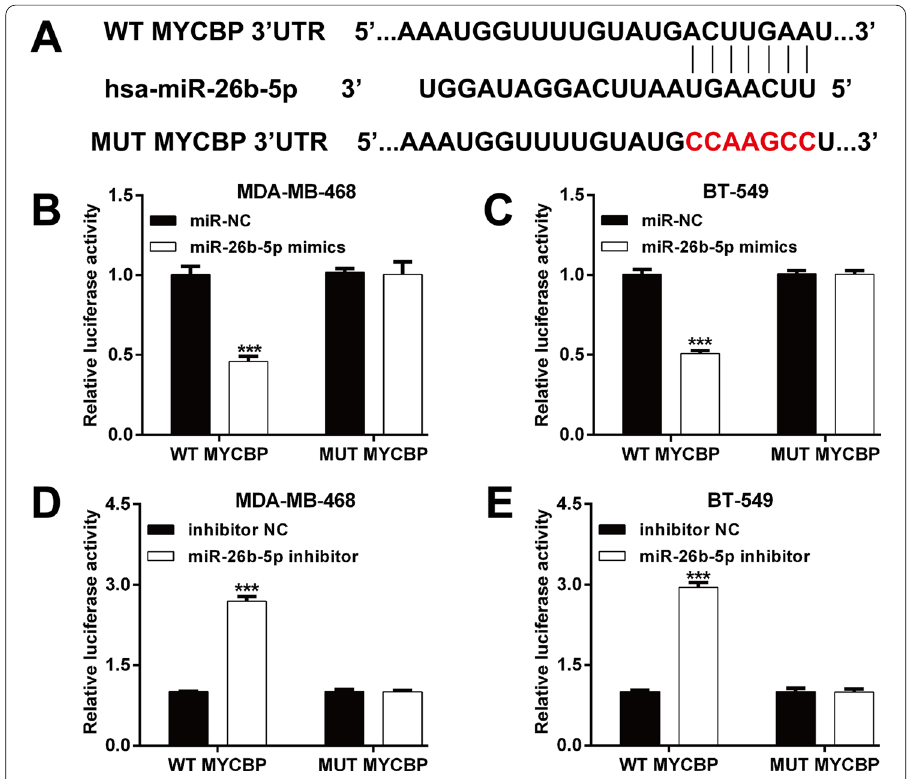
Fig. 1 MYCBP is a direct target of miR-26b-5p. A The binding site for miR-940 in the 3- ′ UTR of FOXO3 predicted by bioinformatics was presented. Luciferase reporter assay evaluation of the interaction between miR-26b-5p and the 3 ′ -UTR of MYCBP mRNA. Luciferase activity was determined 48 h after co-transfection of luciferase constructs containing the wild-type (WT) or a mutated (MUT) 3 ′ -UTR of MYCBP mRNA and miR-26b-5p mimics or miR-NC in MDA-MB-468 ( B ) and BT-549 ( C ) cells. Luciferase activity was determined 48 h after co-transfection of luciferase constructs containing the WT or a MUT 3 ′ -UTR of MYCBP mRNA and miR-26b-5p inhibitor or inhibitor NC in MDA-MB-468 ( D ) and BT-549 ( E ) cells. Data represent the mean of three independent experiments. *** p < 0.001, compared with miR-NC or inhibitor